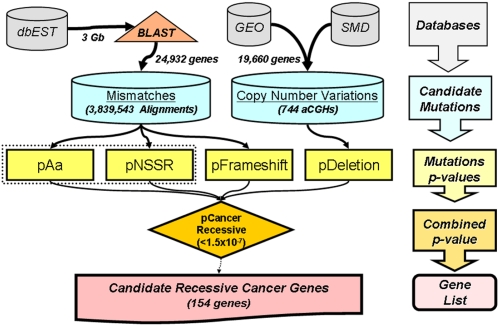
The rationale for selection of candidate recessive cancer genes.The diagram shows the steps in the procedure for the evaluation of mutation probabilities and the data flow towards the identification of candidate recessive cancer genes. Molecular data were extracted from public databases (dbEST and GEO at NCBI, and Stanford Microarray Database). A very large number of alignments (over 4.5 million) was obtained for over 24,000 human genes from BLAST analysis of 3 Gbases of EST sequences. The alignments were parsed to extract mismatches which were deposited in the Cancer Mutome local SQL database. The mismatches were then evaluated by specific procedures to associate mutational p-values to each human gene. In parallel, almost 20,000 human genes were assayed from 744 array CGH to define their propensity to deletion in cancer. The specific mutational p-values were combined to produce a recessive cancer p-value. A genome subset of 154 genes, among which TP53, PTEN, CDKN2A and CDKN2B were present, was selected (cancer p-value<1.5×10−7).